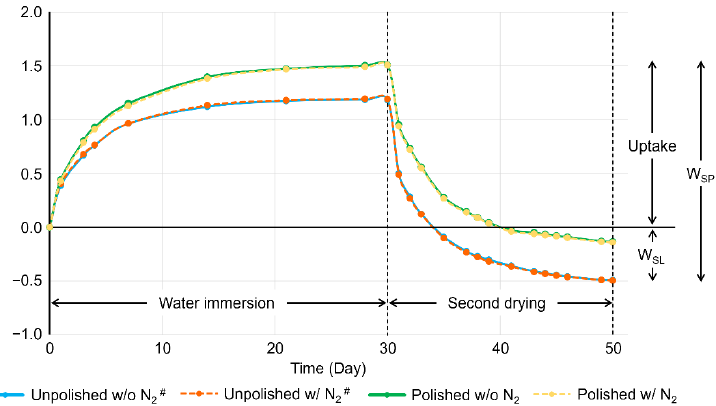
Figure 6. The representative plots of mass changes (%) against time during the water immersion and the second drying procedures. w/o N 2 : stroboscopic post-curing in the air atmosphere. Post- curing w/ N 2 : stroboscopic post-curing at a nitrogen gas atmosphere. It was noted that saturation was achieved 14 days after water immersion and drying was completed 20 days after drying began in all groups. # : data of unpolished subgroups were quoted from the previous study [19].